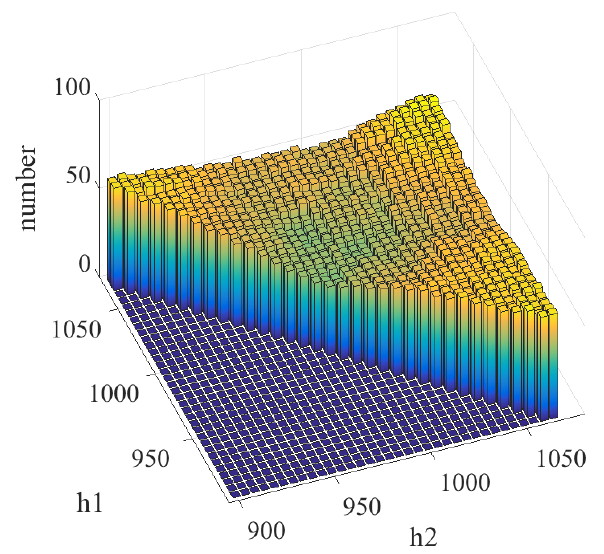
Figure 28. Statistical results of the objective function.